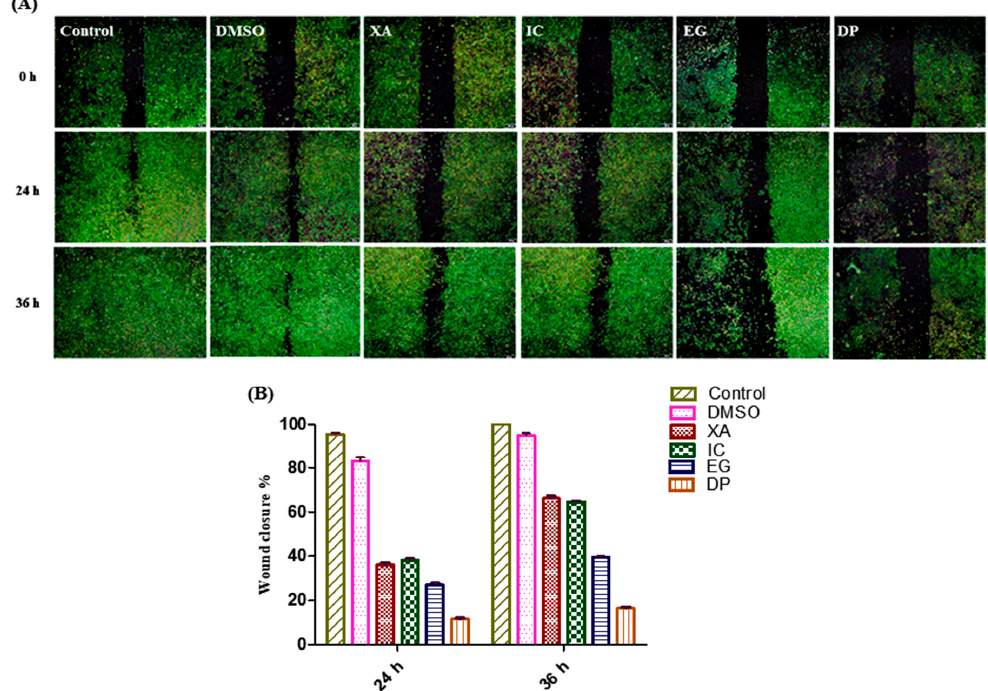
Figure 9. Effect of the plant extracts on cell growth; Scratching was performed using a 200 µL pipette tip. ( A ) Metastatic progression by scratch test. While, ( B ) Time dependent cell wound closure % under the influence of the four plant extracts XA, IC, EG and DP compared to control (un-treated cells) and cells treated with vehicle (0.1% DMSO) as negative control. Values expressed in mean ± standard deviation